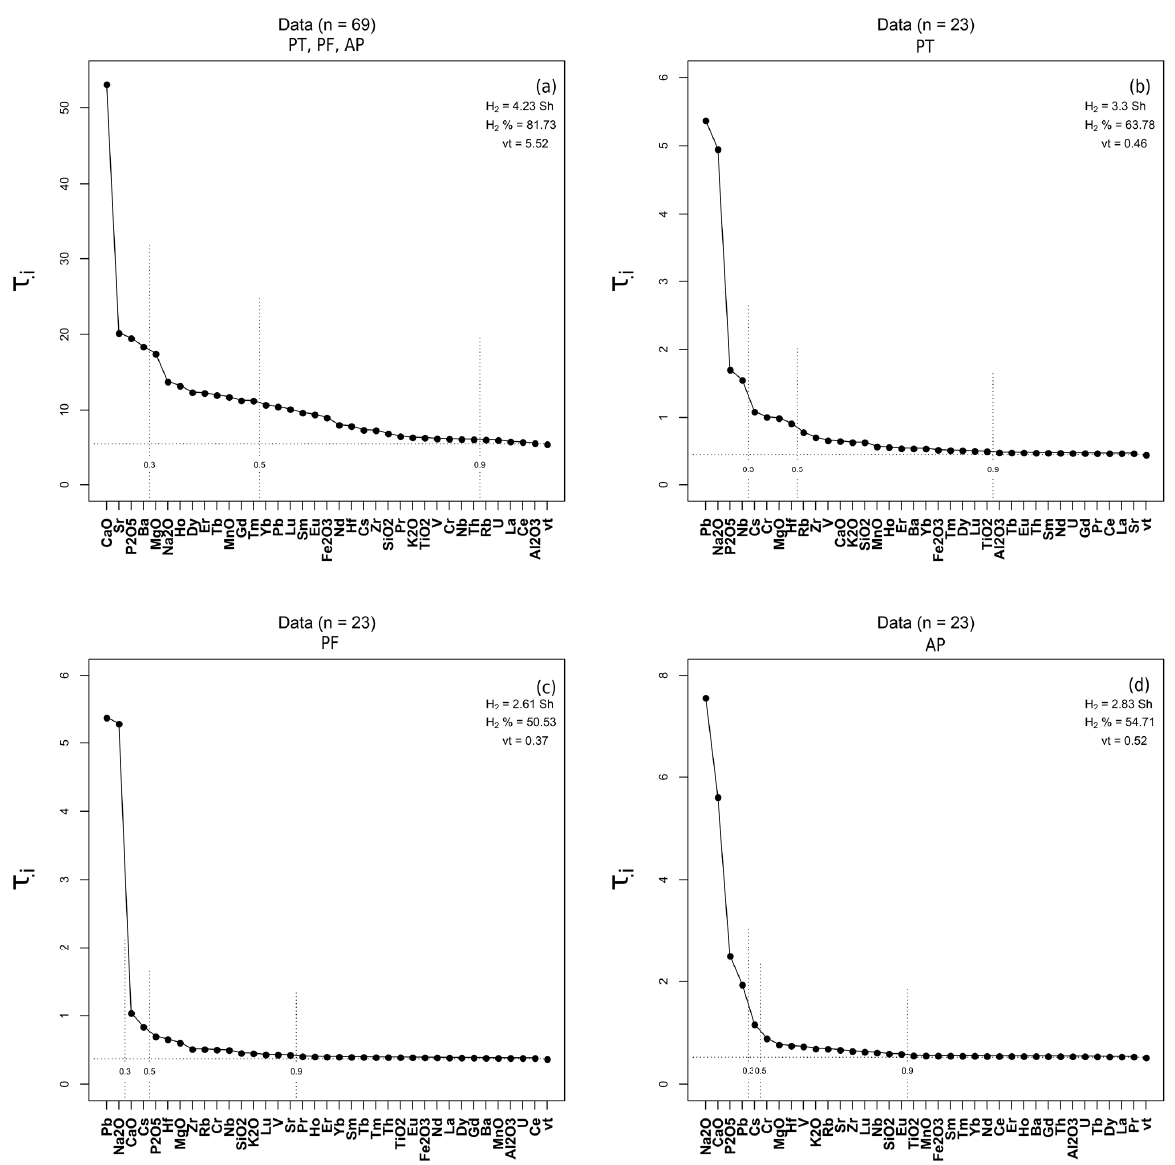
Figure 2. ( a ) Graphical representation of the evenness of the compositional variability of 69 analyzed samples by ICP-MS; ( b ) Graphical representation of the evenness of the compositional variability of 23 analyzed PT samples by ICP-MS; ( c ) Graphical representation of the evenness of the compositional variability of 23 analyzed PF samples by ICP-MS; ( d ) Graphical representation of the evenness of the compositional variability of 23 analyzed AP samples by ICP-MS. Co, Ta, Sn, Cu, Zn and Ni were omitted in all the graphs. (y-axis ( τ .i) = the calculated value for the log-ratio variation for each element in the dataset; vt = Total variability; H 2 = information entropy; H 2 % = percentage of information entropy over the maximum possible; n = number of specimens).